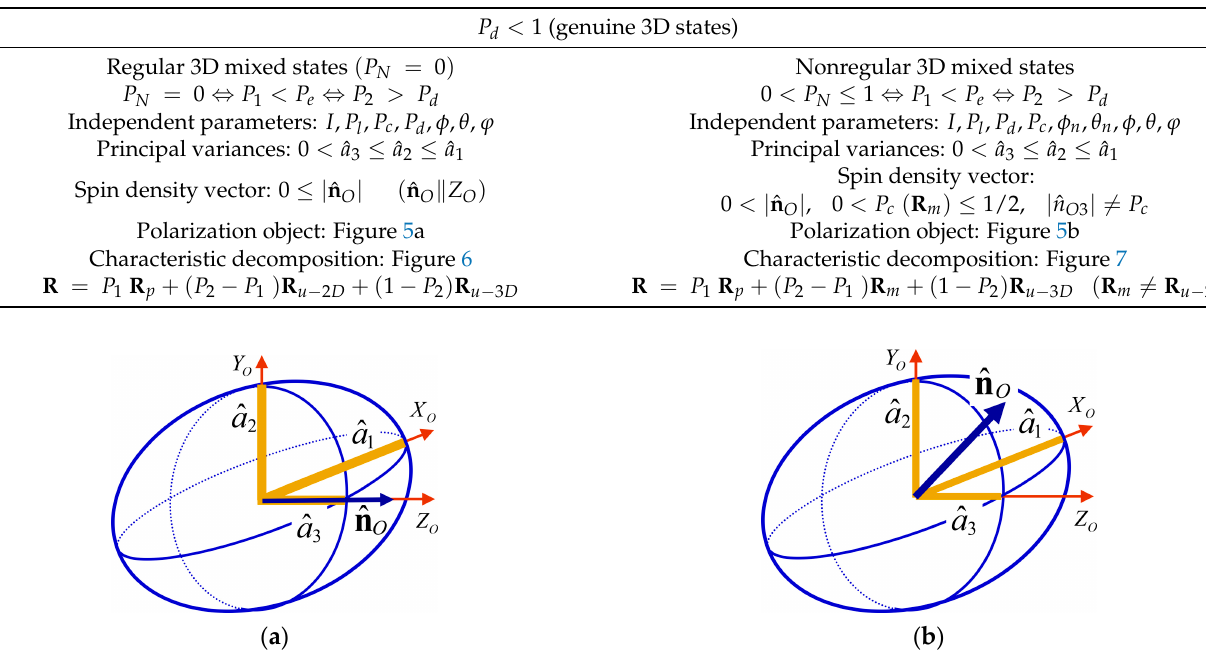
Figure 5. Polarization density object of genuine 3D states ( P d < 1 ) . ( a ) The 3D state is regular when the spin density vector ˆ n O is orthogonal to the plane X O Y O . ( b ) the state it is nonregular if and only if ˆ n O is not orthogonal to X O Y O .